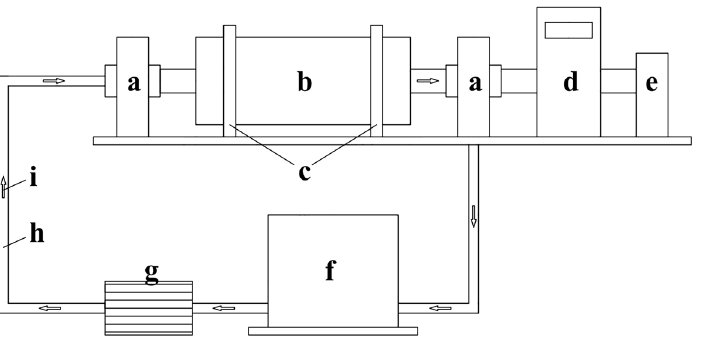
Figure 13. Schematic of the circulation system for pilot testing ( a ) shaft end casings; ( b ) DFDR model machine; ( c ) fixing clamps; ( d ) torque sensor; ( e ) loading device; ( f ) water tank; ( g ) pump; ( h ) water pipes; ( i ) flowing direction.